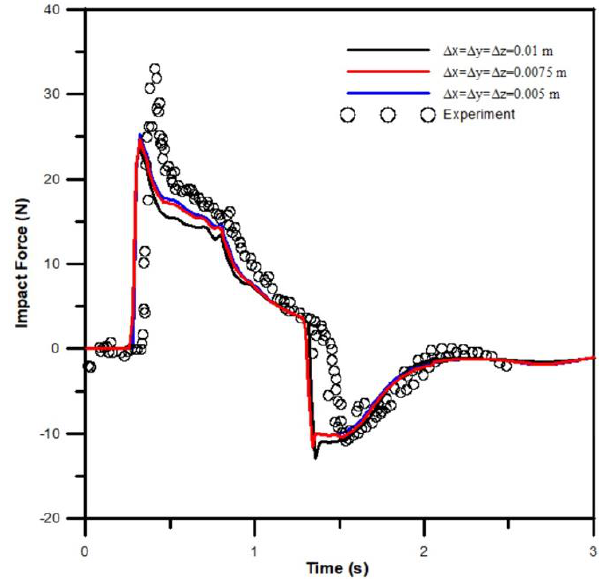
Figure 5. Time history of the impact force on the square obstacle.